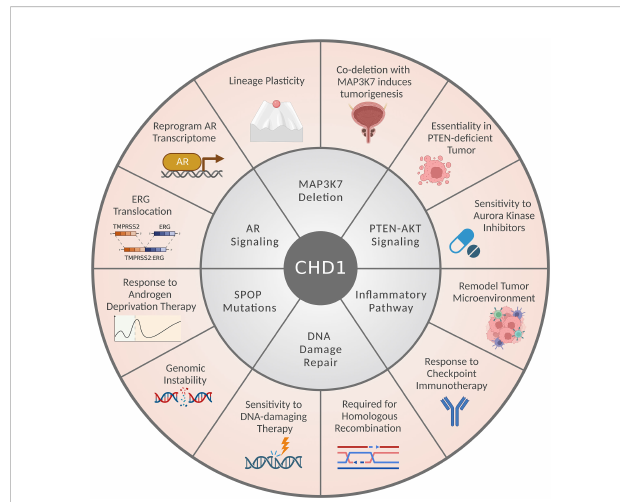
FIGURE 3 CHD1 ’ s multifaceted roles and crosstalk with signaling pathways in prostate cancer. The CHD1-associated signaling pathways or genetic alterations are presented in the middle circle. CHD1 ’ s biological functions and therapeutic implications in prostate cancers are listed in the outer